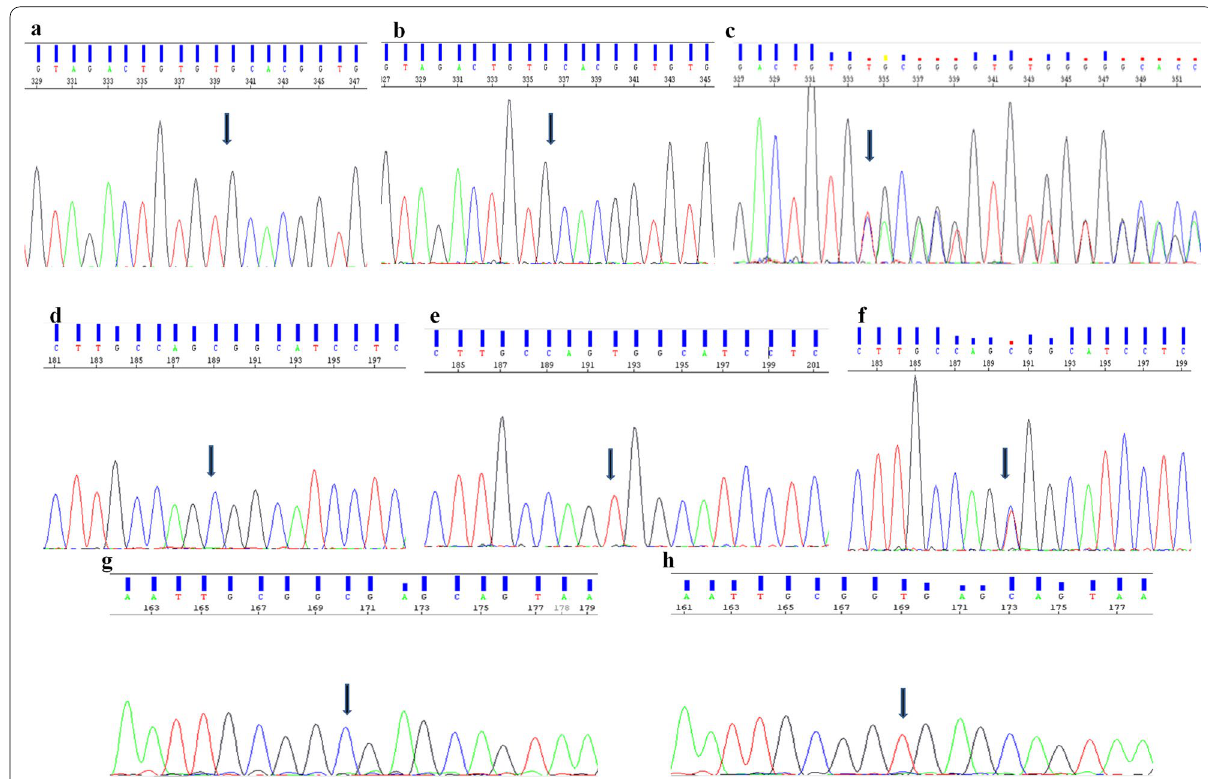
Fig. 1 Sequencing chromatograms of XPC and XPA mutations identified in our cohort. a wild type, b mutation c.1643-1644delTG at a homozygous state sequence and c mutation c.1643-1644delTG at a heterozygous state, d wild type, e polymorphism C.1496 C>T at a homozygous state sequence and f polymorphism C.1496 C>T at a heterozygous state, g wild type, h mutation C.682C>T at a homozygous state